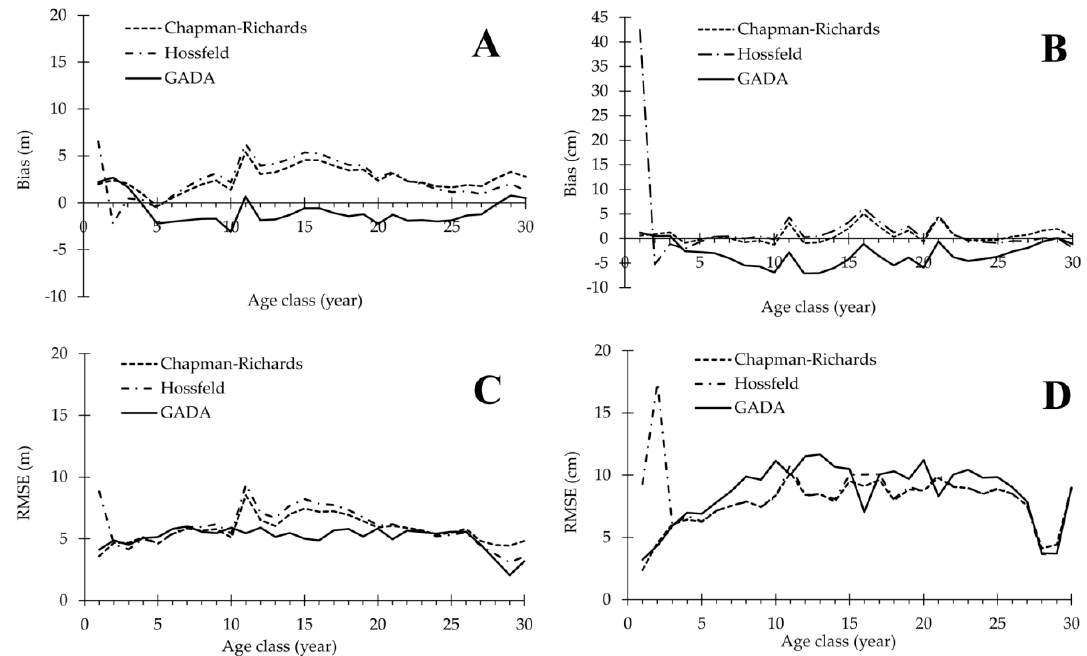
Figure 3. Bias and root mean square error (RMSE) for the mean dominant height and diameter at breast height ( DBH ) predictions yielded by the GADA (generalized algebraic difference approach) formulation (of the Chapman-Richards model) and by the Chapman-Richards and Hossfeld models (( A , C ) for height and ( B , D ) for DBH ).